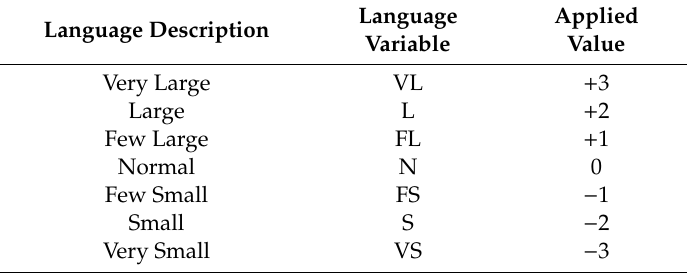
Table 1. Common language variable definitions.